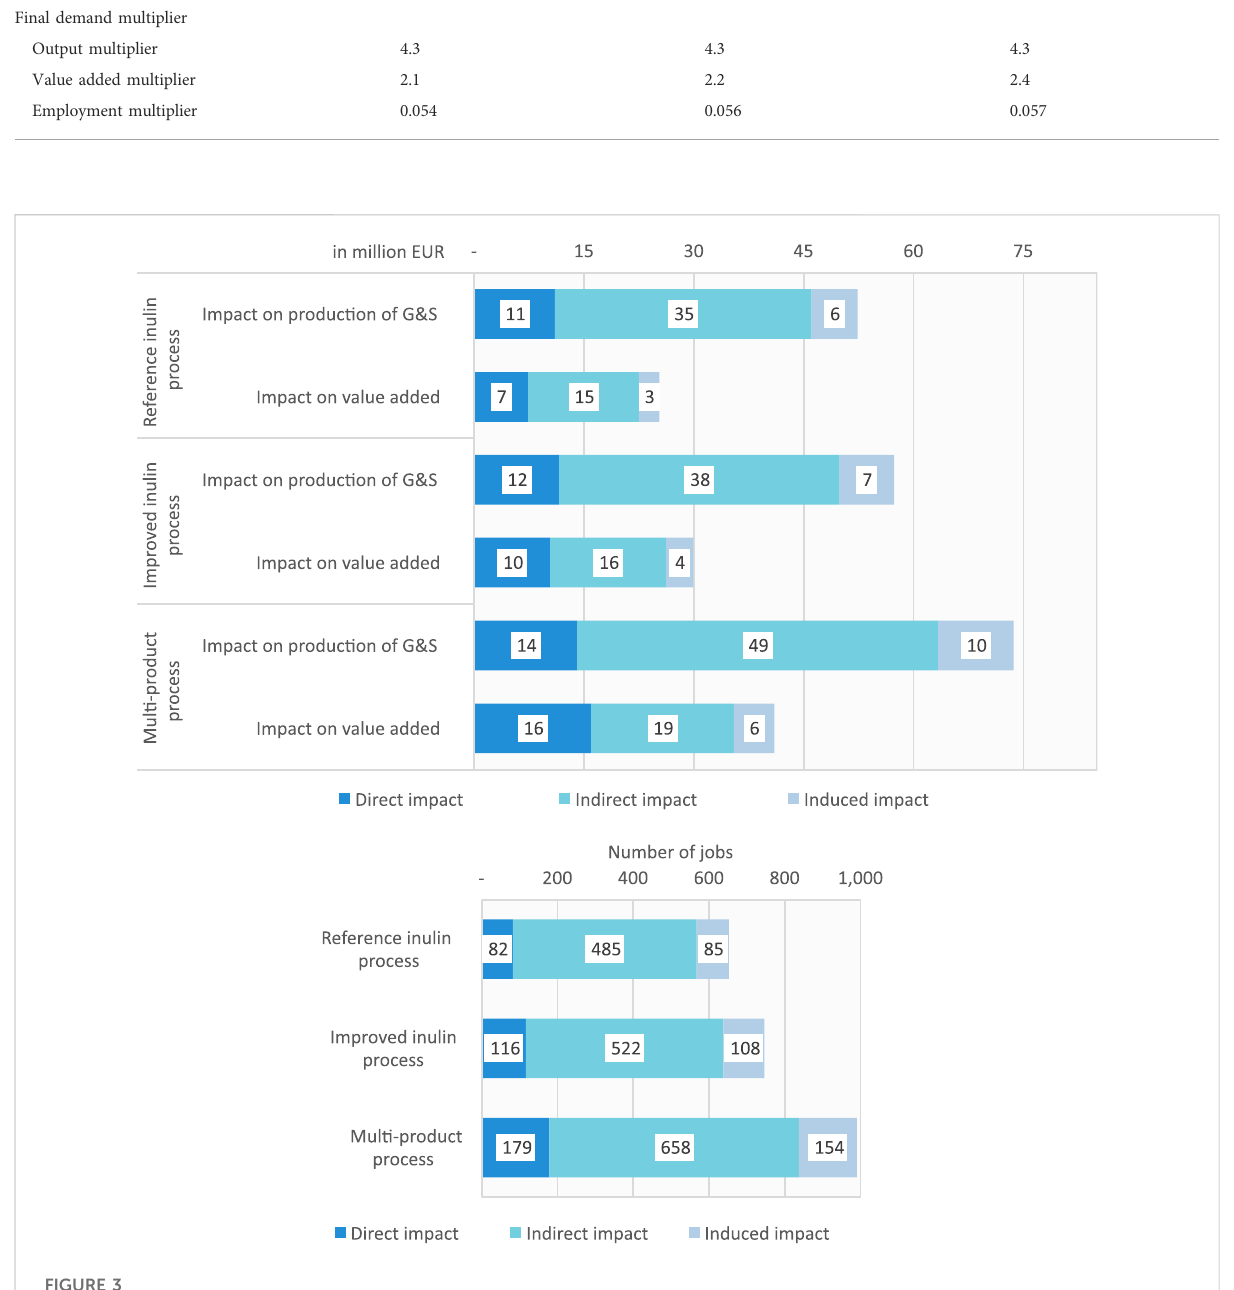
Frontiers in Genome